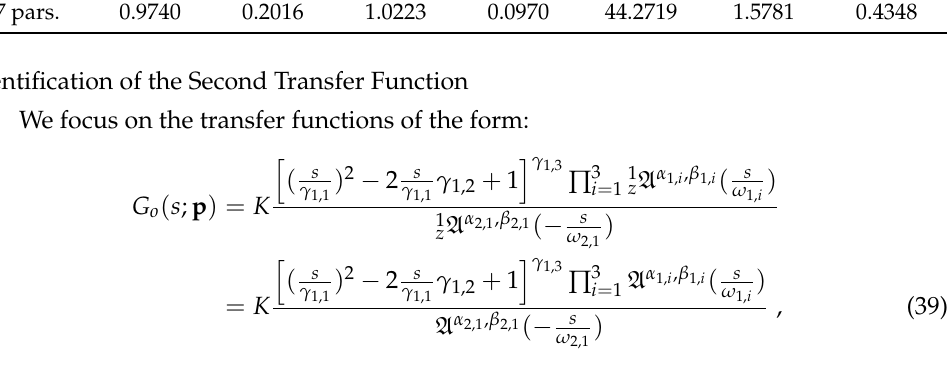
Figure 9. Comparison of the frequency responses of the fitted high-order ARX model and the complex-order model (first transfer function). Table 1. Parameters of the fitted 7-parameter complex-order model. K ω 1 α 1 β 1 ω 2 α 2 β 2 7